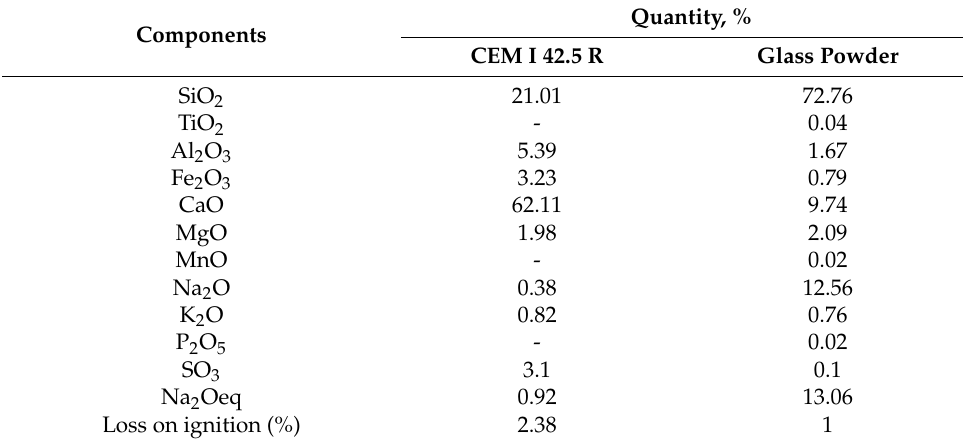
Figure 1. This is a figure. Schemes follow the same formatting. Table 1. Chemical composition of portland cement and glass powder.